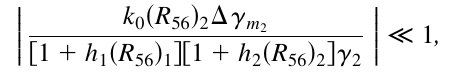
with the SC wiggler off (solid 0